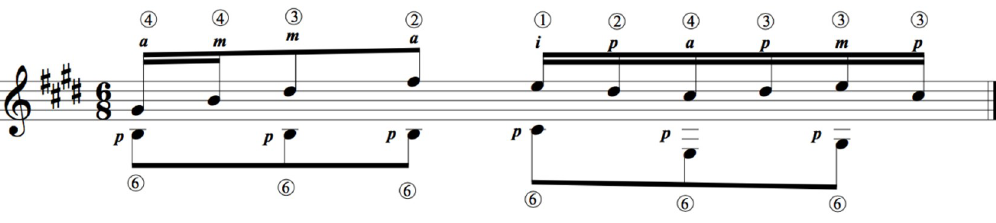
Figure 5. Physically Impossible.